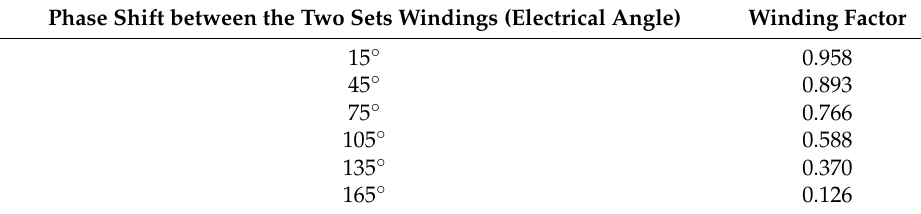
Table 3. Winding factor with different phase shifts in the 24-slot/10-pole six-phase winding layout.